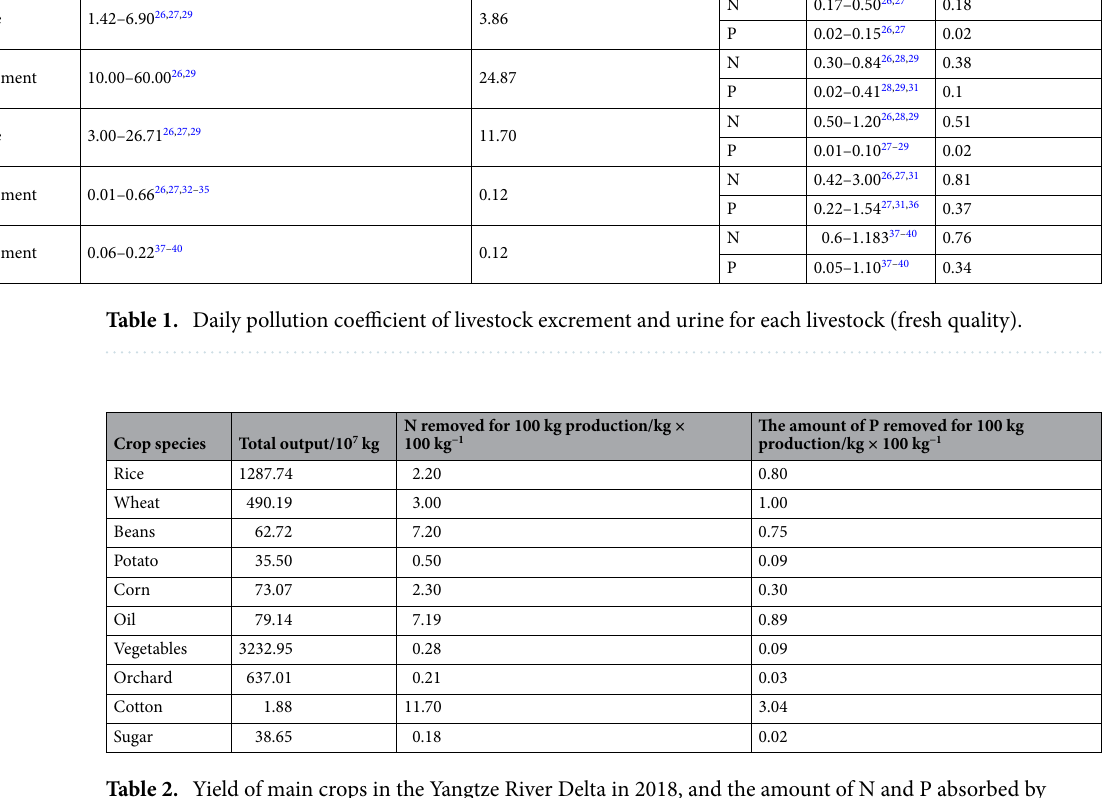
Table 2. Yield of main crops in the Yangtze River Delta in 2018, and the amount of N and P absorbed by 100 kg of yield.